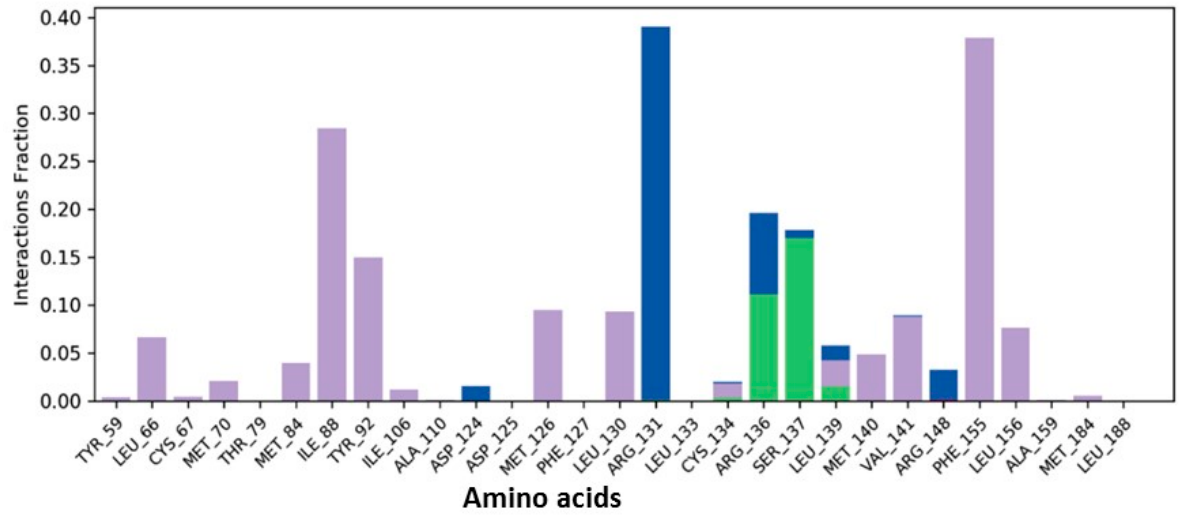
Figure 6. Ligand RMSF plot of beta-sitasterol in complex with 6IE9: X -axis depicts atom index and Y -axis reveals RMSF (Å).20 stands for atom number which is oxygen